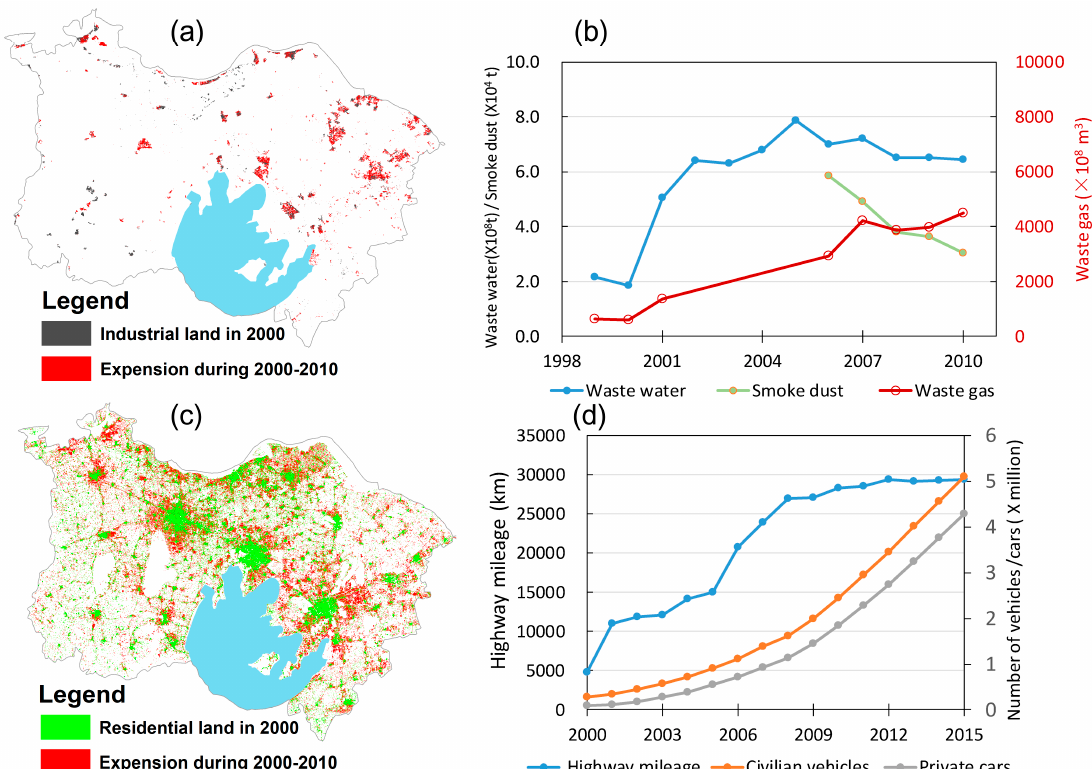
Figure 10. Changes in industrial and residential lands and the amounts of the industrial waste discharges over the period of 2000–2010, and the transportation-related information during 2000–2015 (land cover data were sourced from Land Cover Atlas of the People’s Republic of China (1:100,000), Land Cover Atlas of the People’s Republic of China Editorial Board [33], and other data were sourced from the Jiangsu Bureau of Statistics, http://tj.jiangsu.gov.cn).( a ) changes in industrial land; ( b ) changes in residential land; ( c ) industrial waste discharge; ( d ) transportation-related changes.